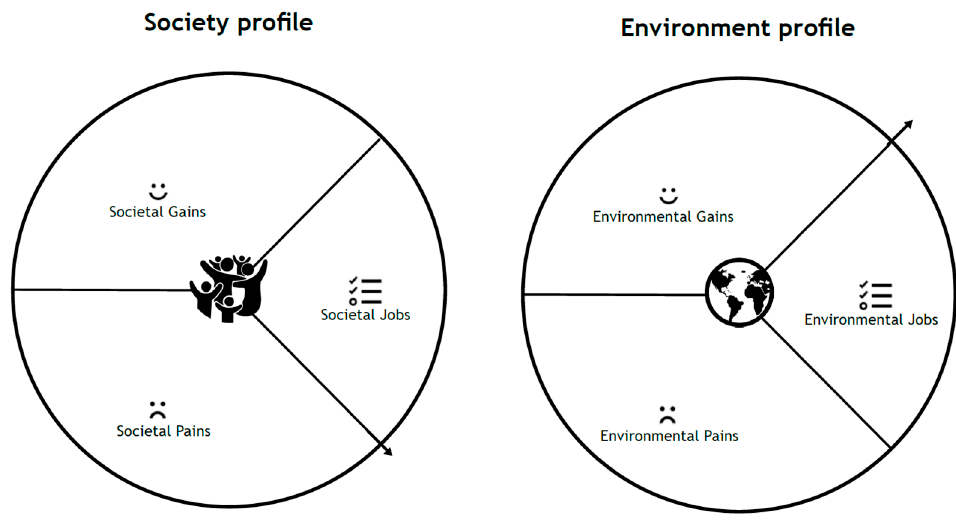
Figure 2 . Overview of societal and environmental pro fi le. Figure 2. Overview of societal and environmental